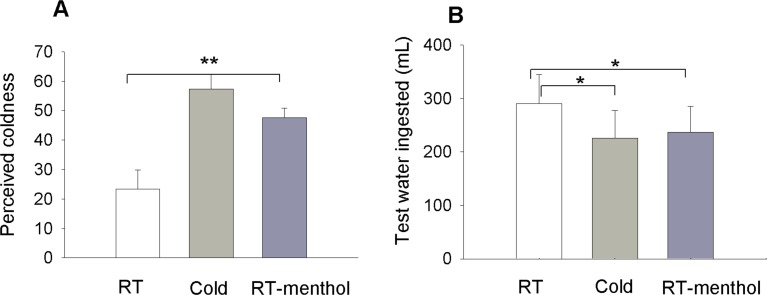
Effects of oral cold stimulation induced by menthol on thirst quenching.Figures display the volume of extra room temperature (RT) water ingested 15 min after consuming a 400 mL experimental beverage. In this study all the experimental beverages were presented with a pretreatment, either blank or containing 0.04% l-menthol. The pretreatment solutions were presented at RT. Legends correspond to the experimental beverage tested with mention of menthol when present in the pretreatment. All the experimental beverages were tested in duplicate. (A) Coldness ratings of the experimental beverages: RT water (21°C) vs Cold water (6°C) vs RT water (21°C) with menthol-pretreatment (n = 12 participants). (B) Volume of extra RT water consumed. Data are represented as mean +/- SEM. ** indicates statistical significance at p< 0.01 and * at p<0.05.